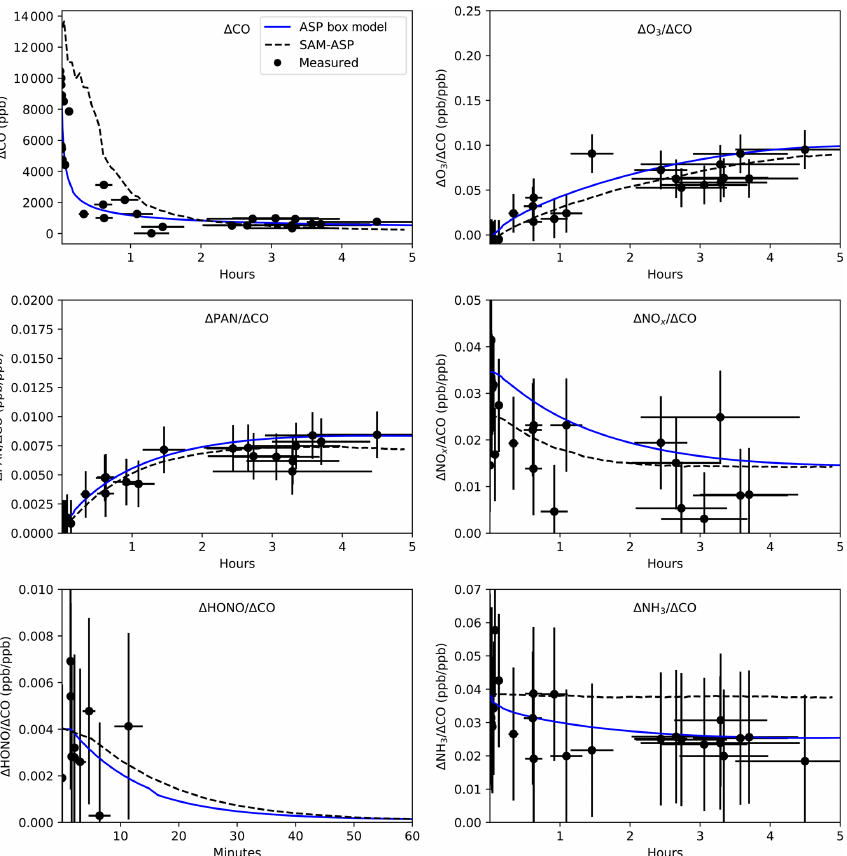
Figure 4. Cross-plume-averaged (cid:49) CO and O 3 , PAN, NO x , HONO, and NH 3 NEMRs ( (cid:49) X /(cid:49) CO) as a function of plume age for the ASP box model (solid line, reproduced from Alvarado et al., 2015) and SAM-ASP model (dashed line) results compared to measurements from Akagi et al. (2012) (dots). The horizontal error bars indicate the age uncertainty of the measurements, while the vertical errors bars are the uncertainty of the measured